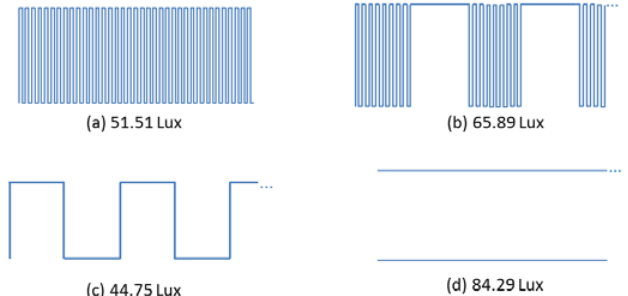
Figure 12. Light intensity measurements for different frame parts of ( a ) carrier burst; ( b ) OOK signal used for preamble and pattern; ( c ) OOK with the data bit rate chosen, and ( d ) for a reference signal of always on.